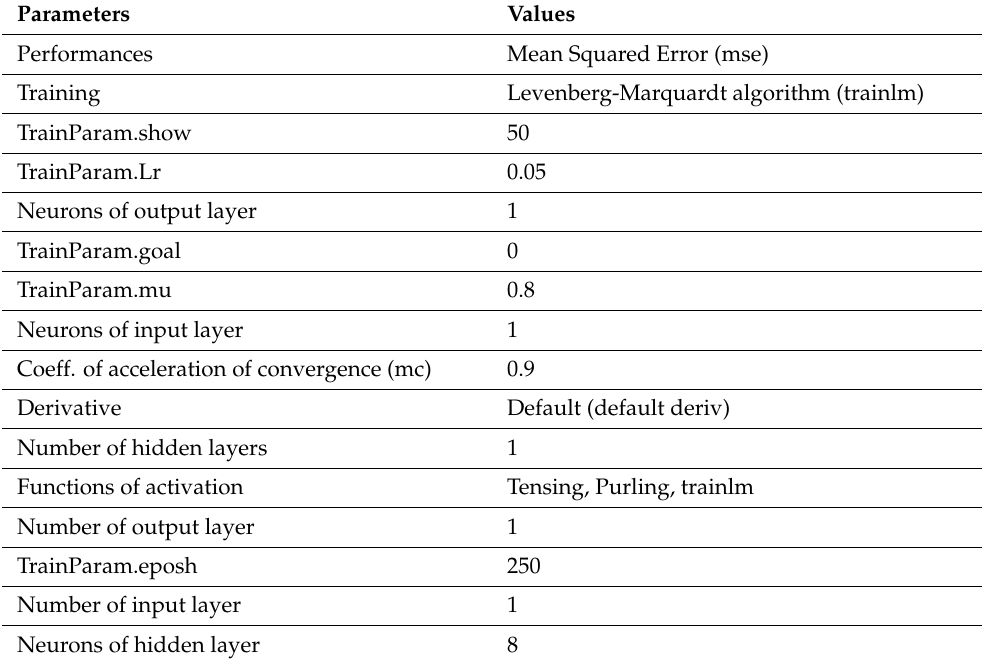
Table A4. Parameters of the FNN